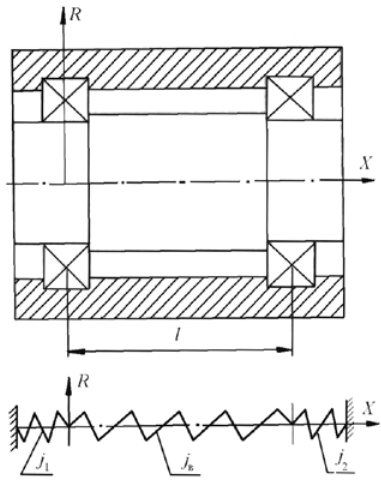
Fig.3. Typical thermoelastic model (the spindle, the lead screw) with elastic